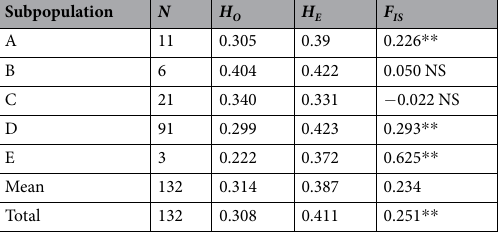
Table 1. Diversity statistics. N – number of samples; H O – observed heterozygosity; H E – expected heterozygosity;